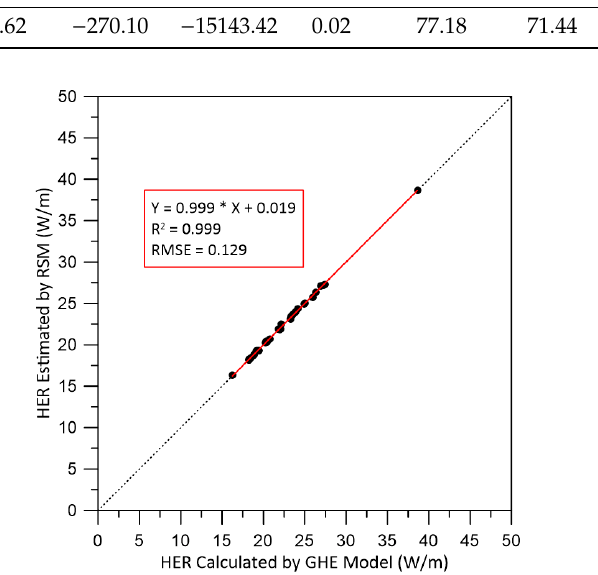
Figure 9. Distribution of thermal conductivity and simulation result of the GHE model. The distribution was set as ( a ) 1.5 W/(mK), ( b ) 1.0 W/(mK) from top to 50 m depth and 2.0 W/(mK) from 50 to 100 m depth, ( c ) 1.3 W/(mK) from top to 50 m depth and 1.7 W/(mK) from 50 to 100 m depth, ( d ) 1.7 W/(mK) from top to 50 m depth and 1.3 W/(mK) from 50 to 100 m depth, and ( e ) 2.0 W/(mK) from top to 50 m depth and 1.0 W/(mK) from 50 to 100 m depth. The arithmetic average values of thermal conductivity were 1.5 W/(mK) in all scenarios.